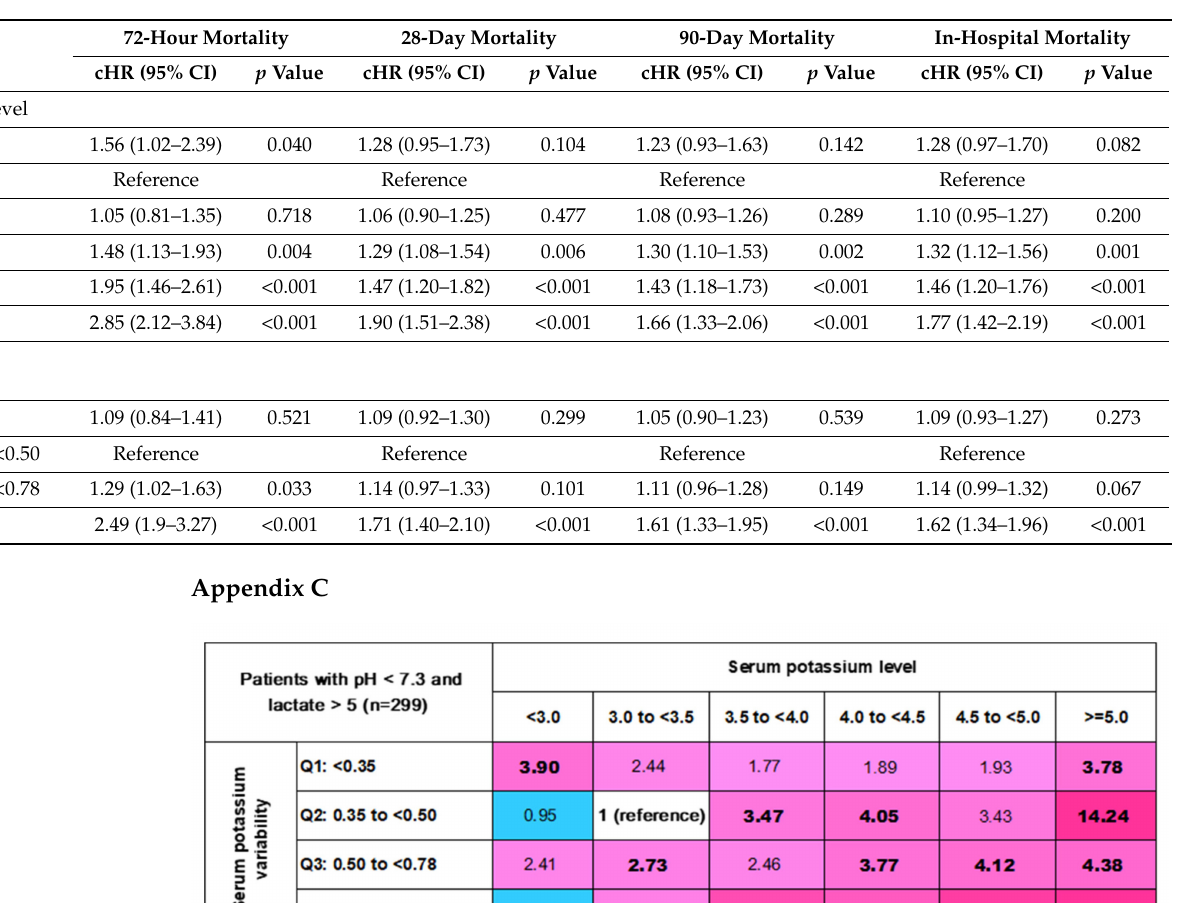
Table A2. Crude hazard ratio for 72 h, 28-day, 90-day, and in-hospital mortality.